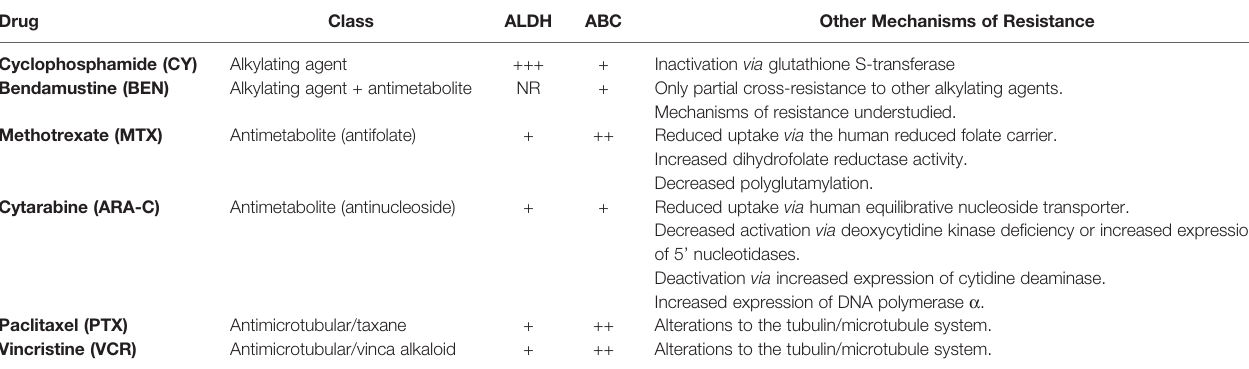
TABLE 1 | Putative pathways of resistance to chemotherapeutics tested in this study as assessed by available literature (8, 12 – 14, 19 –